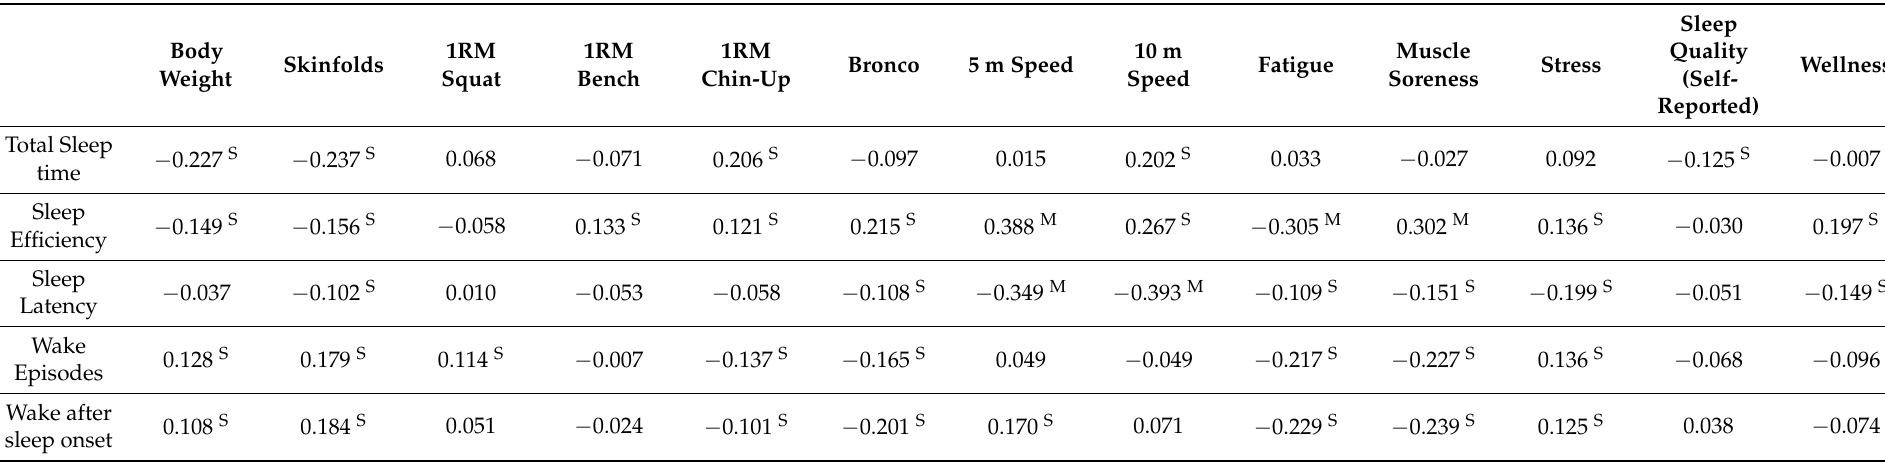
S = small correlation, M = moderate correlation. Table 2. Differences in sleep duration as assessed via wrist-actigraphy (mean ± SD) for the HIGH and LOW sleep groups across a 3-week data collection period. Sleep Duration Sleep Duration Nightly (h:min)